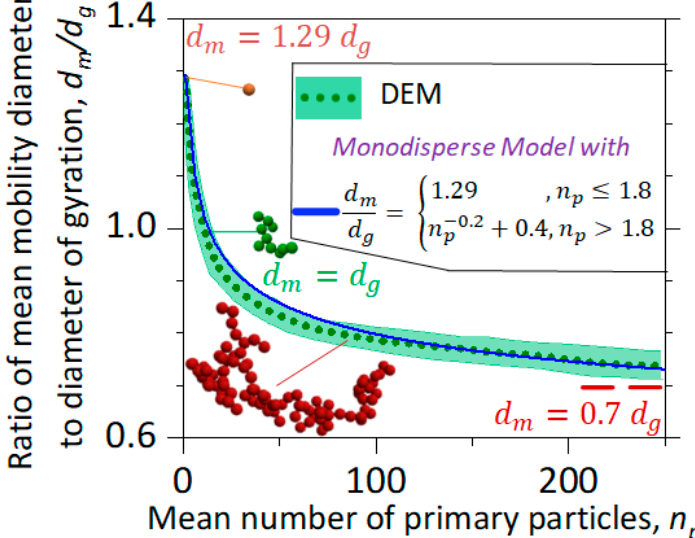
Figure 3. Evolution of the ratio of the mean mobility diameter over that of gyration, d m / d g , as a function of n p during agglomeration derived by DEM (dotted line and green shade) and the MPBM interfaced with Equation (2) (solid line). The d m / d g is initially equal to 1.29 for single spheres [40], but rapidly decreases to 1 for agglomerates with n p ∼ 10 and σ g , p = 1 and asymptotically reaches 0.7 (dashed line) for large agglomerates with n p ≥ 700 [41]. The DEM-derived relation [10] (solid line, Equation (2)) quantifies the evolution of d m / d g within 6% of the DEM